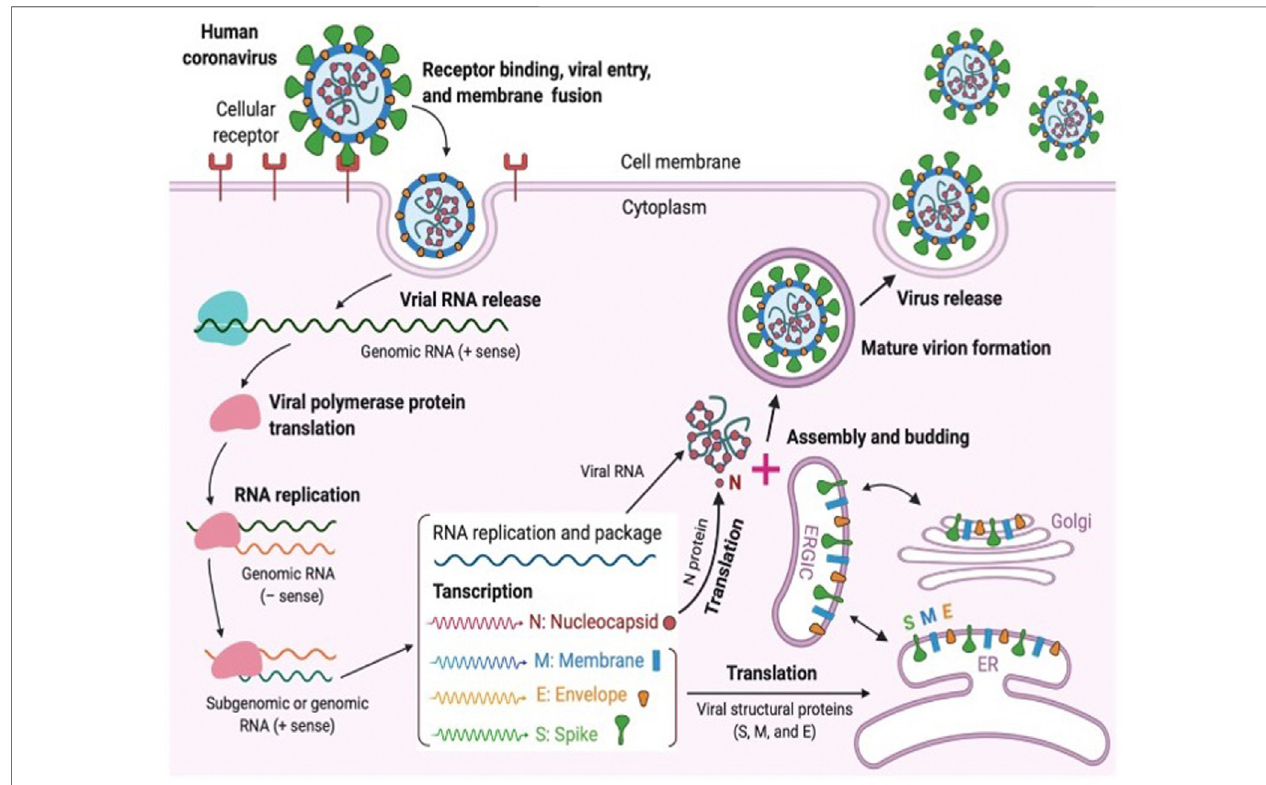
FIGURE 2 | Coronavirus replication cycle [(Jiang et al., 2020) Copyright ©2020 Elsevier Inc., based on the reuse provisions of Elsevier ’ s COVID-19 Resource Center].